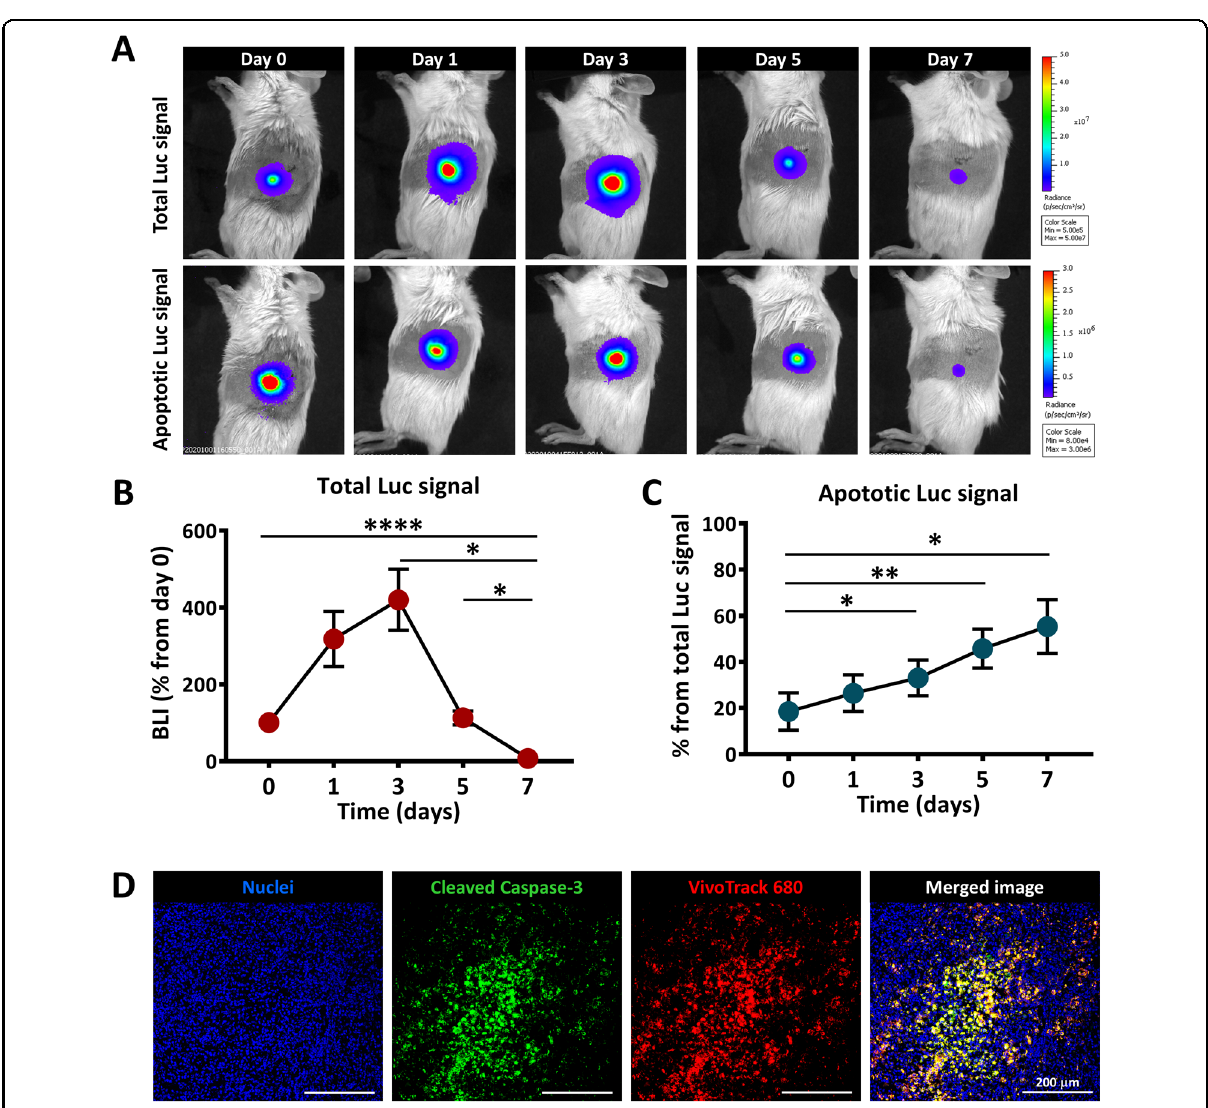
Fig. 4 In vivo apoptosis of MSC after intrapancreatic transplantation. A Representative BLI time-course images obtained after injection of D- Luciferin (for detection of total viable cells) or Z-DEVD-aminoluciferin (for detection of apoptotic cells), after intrapancreatic transplantation of Luc + MSC; B Quanti fi cation of BLI signal measured after D-Luciferin administration in mice; data are shown as mean ± SEM ( n = 5); C Quanti fi cation of BLI signal measured after Z-DEVD-aminoluciferin administration in mice; data are shown as mean ± SEM ( n = 5). D Immuno fl uorescence images of the pancreas of a NOD mouse at 7 days after MSC local transplantation, indicating cellular apoptosis at the site of transplantation. Note that numerous VT680-labbeled MSC were apoptotic at that time, as revealed by the presence of cells co-stained with VT680 (red pseudo-colour) and cleaved Caspase 3 (green